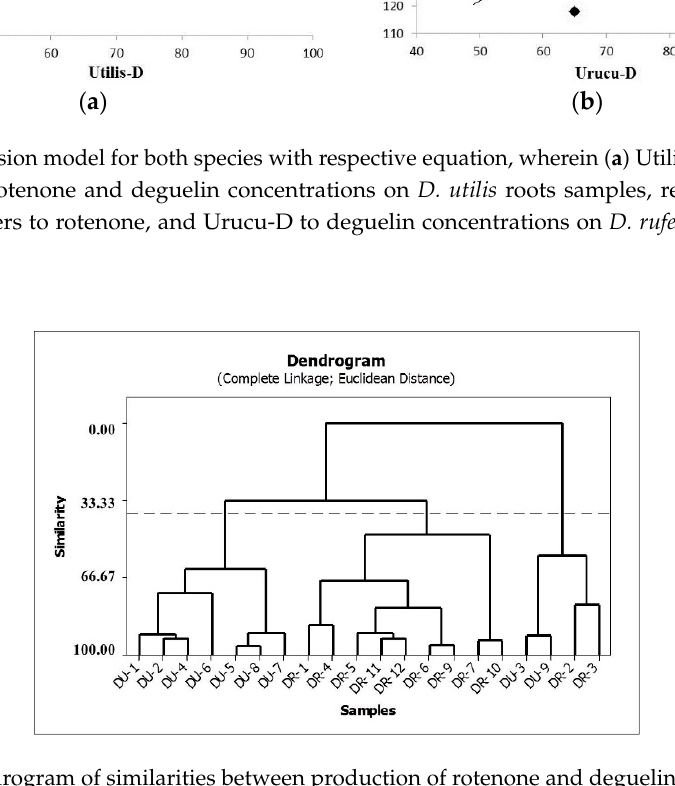
Molecules 2016 , 21 , x